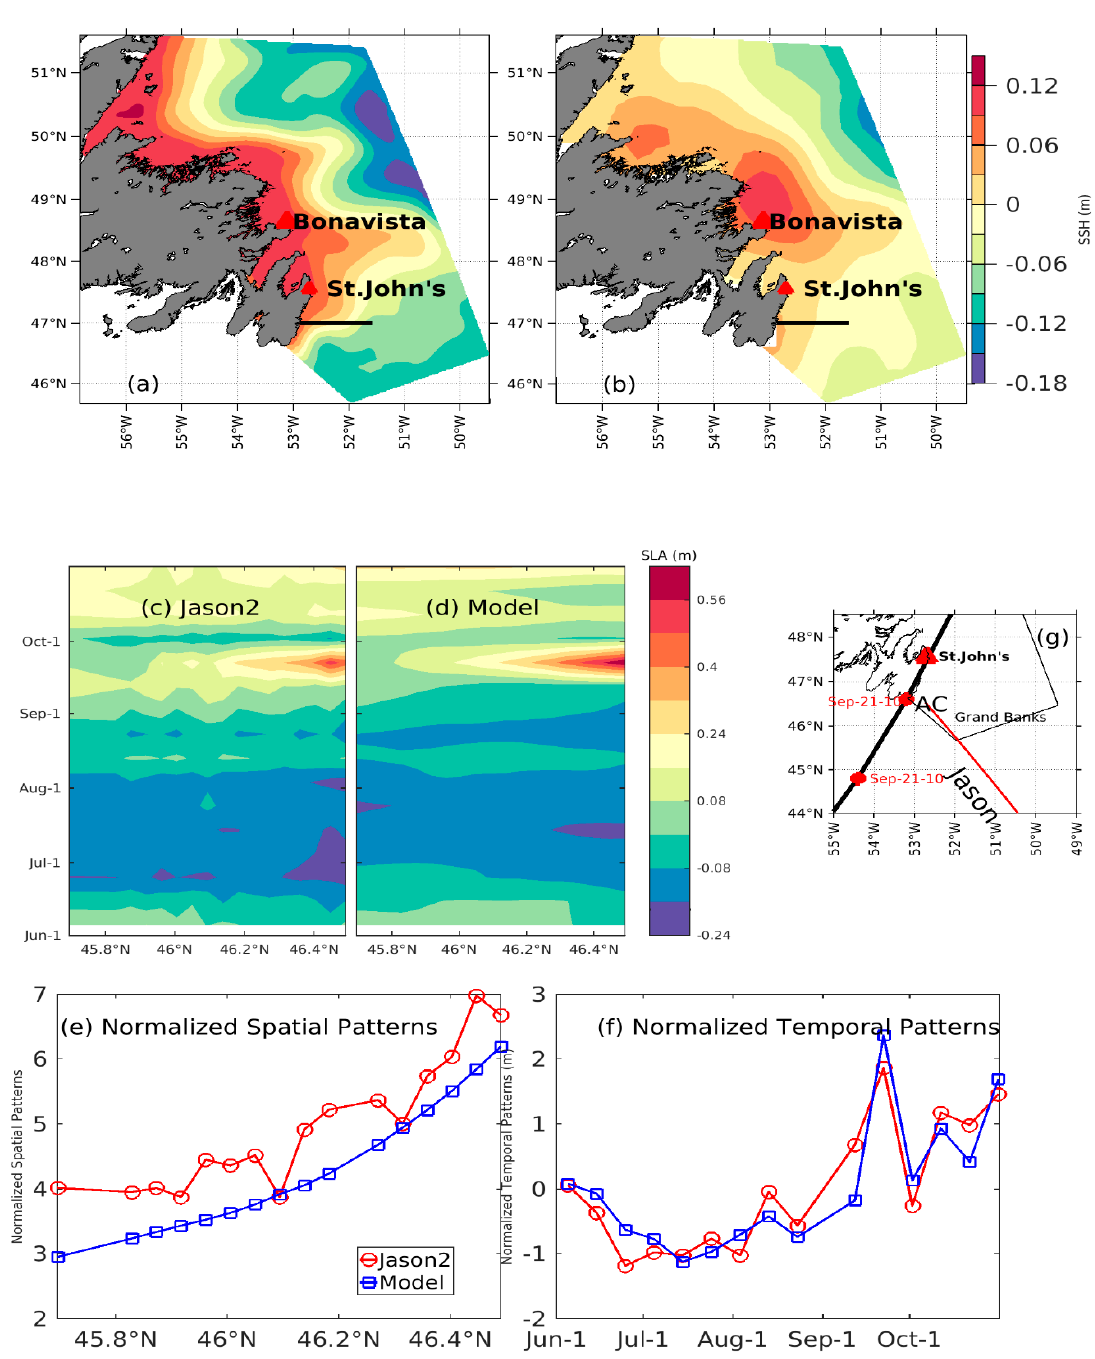
Figure 3. ( a ) Five-month averaged sea surface height (SSH) field off eastern Newfoundland from Finite Volume Community Ocean Model (FVCOM) with its spatial mean removed. ( b ) Five-month averaged absolute dynamic topography derived from multi-mission altimeter data with its spatial mean removed. ( c ) Jason-2 and ( d ) model sea level anomaly (de-tided) from 1 June 2010 to 31 October 2010. ( e ) Normalized Empirical Orthogonal Function (EOF) mode 1 spatial patterns calculated by the first EOF spatial patterns over its own standard deviation. ( f ) As in (e) but for temporal patterns. ( g ) One of the Jason-2 satellite ground tracks (Red) and storm track (Black) with model open boundary. AC in ( g ) is Avalon Channel. Black thick lines in ( a ) and ( b ) indicate locations to estimate the mean magnitude of the inshore Labrador